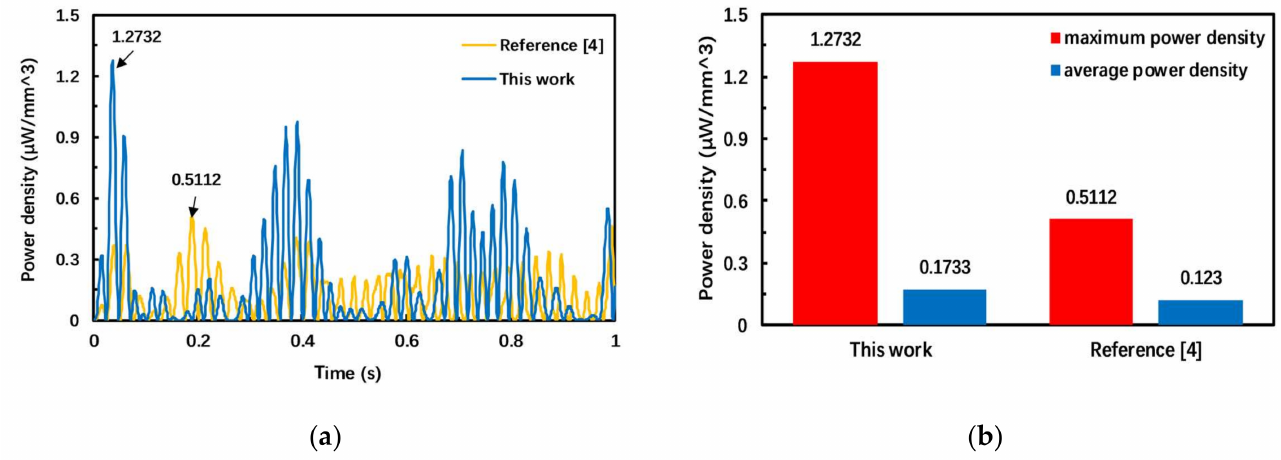
Figure 5. Comparison of output power density of two harvesters. ( a ) Instantaneous output power density during simulation; ( b ) Comparison of maximum and average power